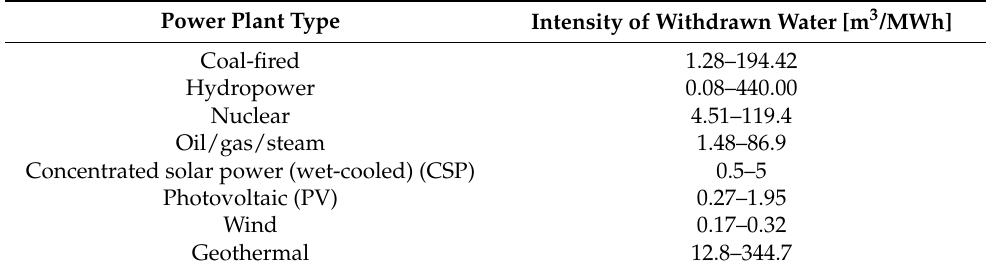
Table 5. Water intensity based on a lifecycle basis according to Southern Africa Development Community (SADC), Regional Water Infrastructure Program; SADC: Gaborone, Botswana, 2010 [37].